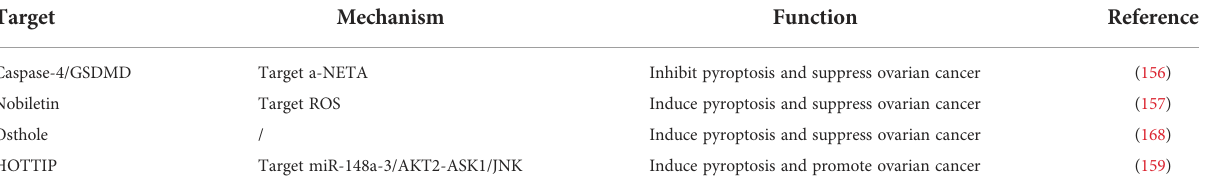
TABLE 4 The regulatory role of pyroptosis-related targets in ovarian cancer progression.